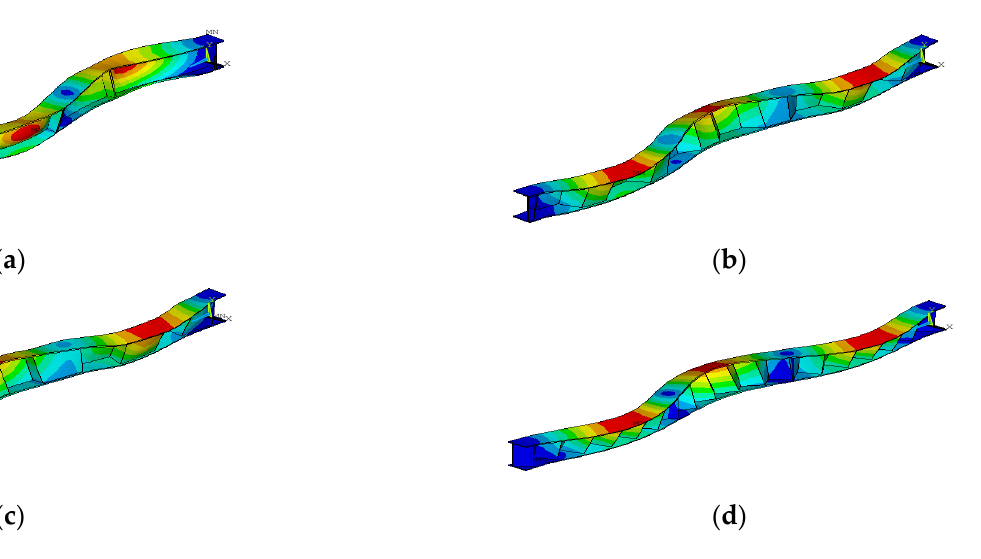
Figure 8. Pattern of 3rd flexure displacement mode shapes: ( a ) flat web with stiffener, ( b ) trapezoidal web, ( c ) rectangular web, and ( d ) triangular web. Table 4. Comparison of experimental and numerical results for the flat web beam with stiffeners. Normalized Displacement/Maximum Num. Flat Web Steel Beam Specimen